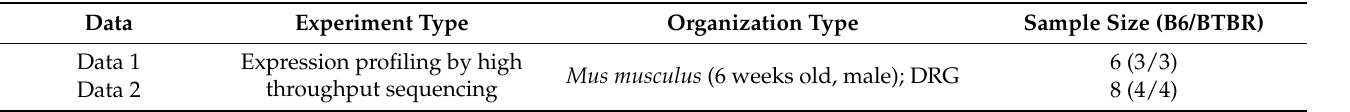
Table 2. The characteristics of the RNA-seq data in the